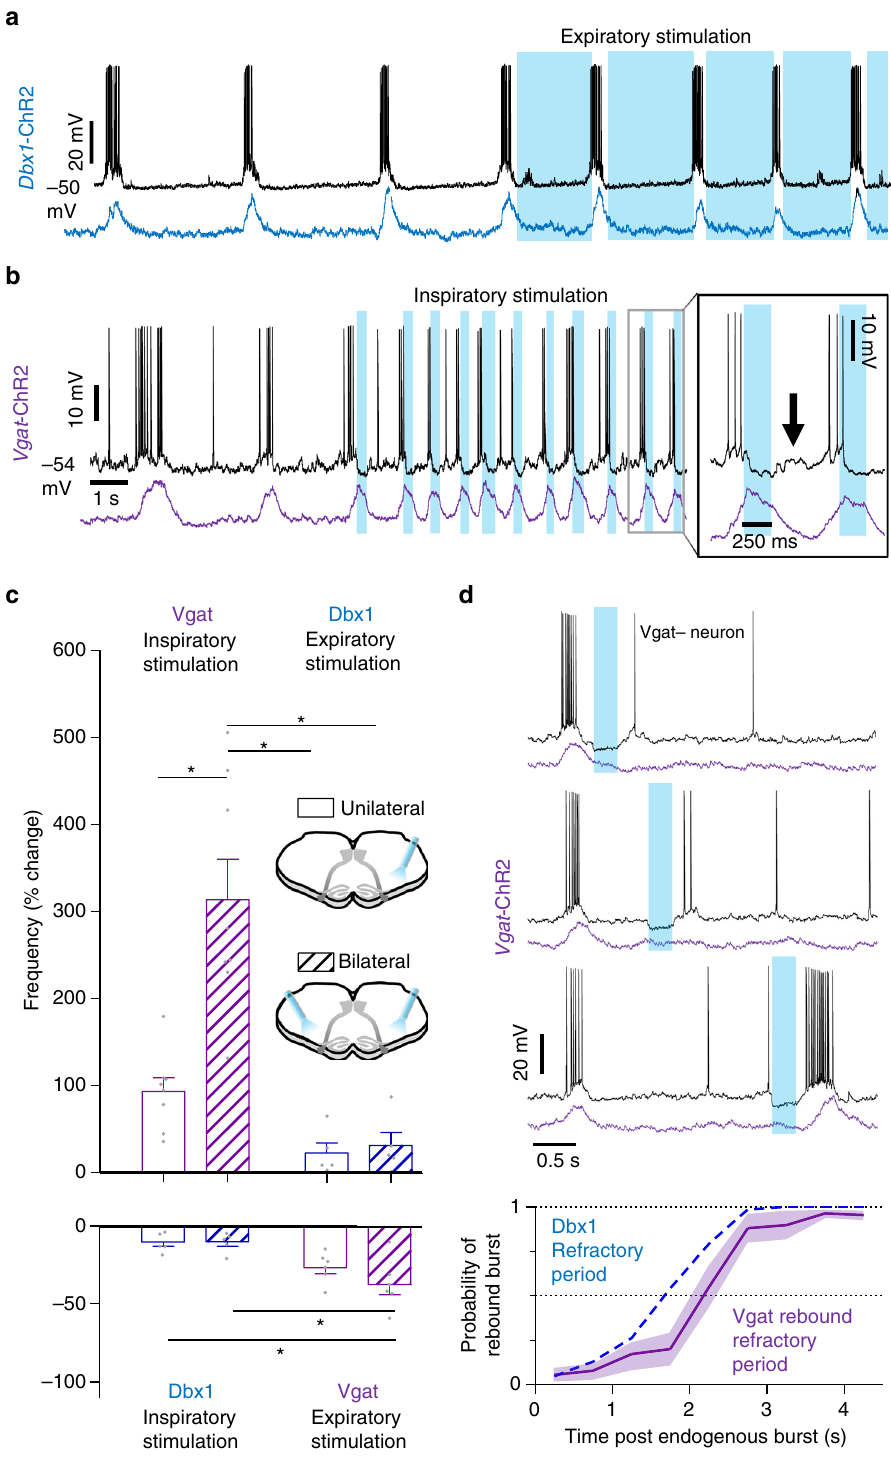
Fig. 5 Phasic inhibition, but not excitation, drives high preBötC burst frequencies. a Representative inspiratory neuron and preBötC population recording during bilateral light stimulation speci fi cally during the expiratory phase in a Dbx1 -ChR2 rhythmic brainstem slice. b Representative inspiratory neuron and preBötC population activity during threshold-triggered bilateral light stimulation speci fi cally during the inspiratory phase in a Vgat- ChR2 slice. c Average changes in frequency in Vgat -ChR2 slices during unilateral and bilateral preBötC stimulation during inspiration ( n = 8) and expiration ( n = 6) compared to Dbx1 -ChR2 stimulation during inspiration ( n = 5) and expiration ( n = 5; one-way ANOVA and Bonferonni ’ s multiple comparisons test; * p < 0.001). d Intracellular recording of a Vgat − neuron and preBötC population activity during brief light pulses (200 ms) in a Vgat -ChR2 slice. Note that rebound spiking is reduced during the refractory period. Quanti fi ed probability of evoking a population burst via postinhibitory rebound relative to the time of light stimulation following an endogenous burst (0.5 s bins; n = 7 slices, ~100 – 150 trials/slice; mean ± s.e.m.) compared to the probability of evoked bursts during Dbx1 stimulation (data shown in Fig. 2b), demonstrating similar refractory